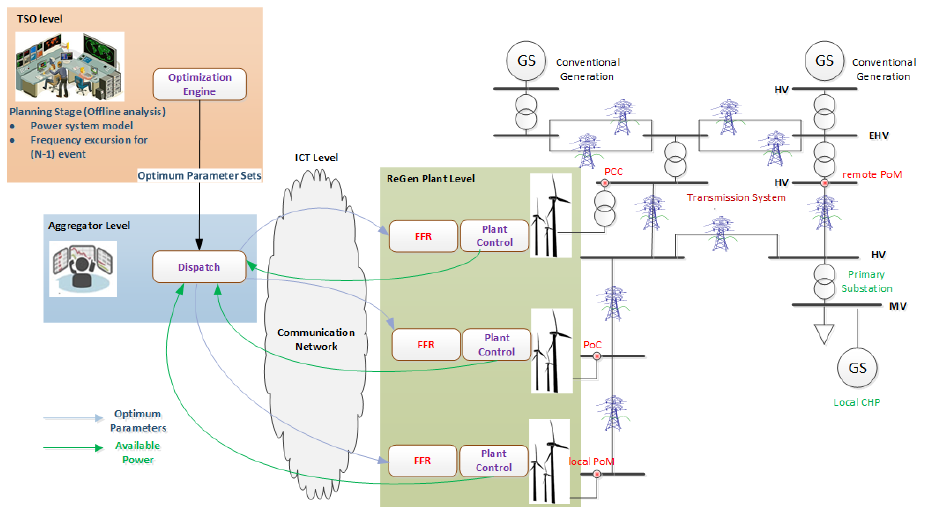
Figure 1. Implementation of Offline Optimization Approach with Control